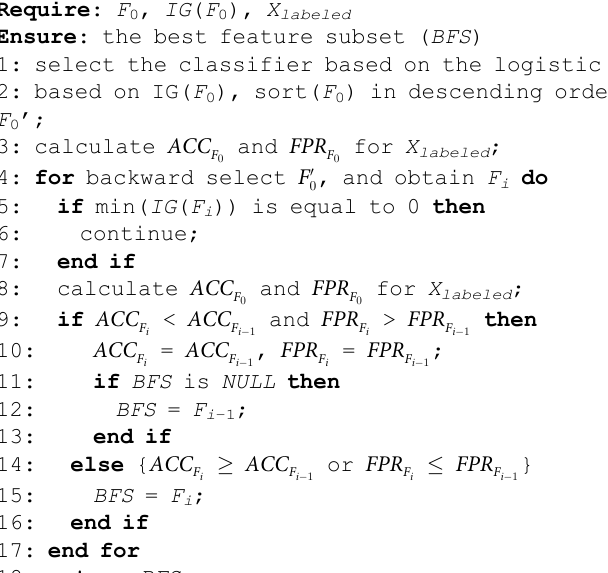
Algorithm 1 Modified wrapper method for feature